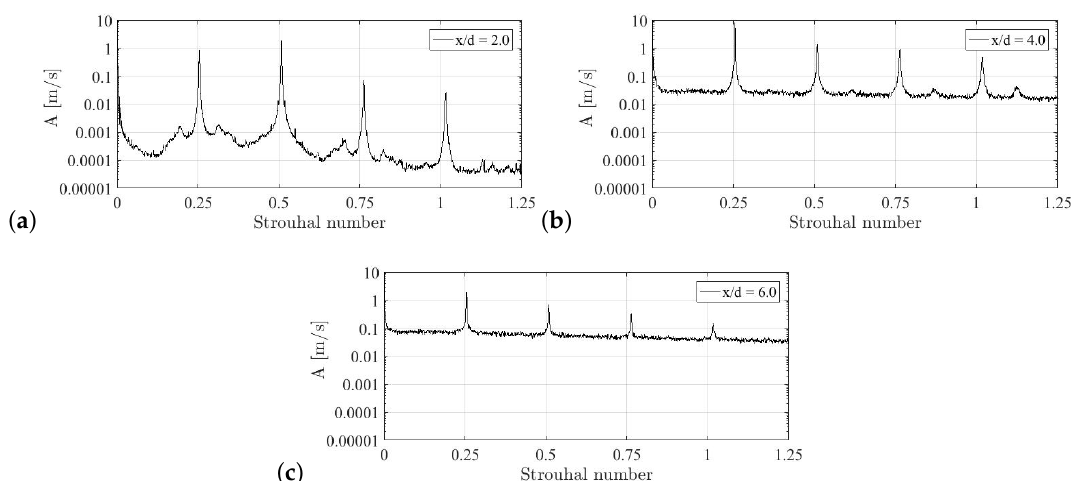
Figure 15. Evolution of spectra of axial velocity fluctuations, S = 0.5, L / D = 7, Re = 10,000: